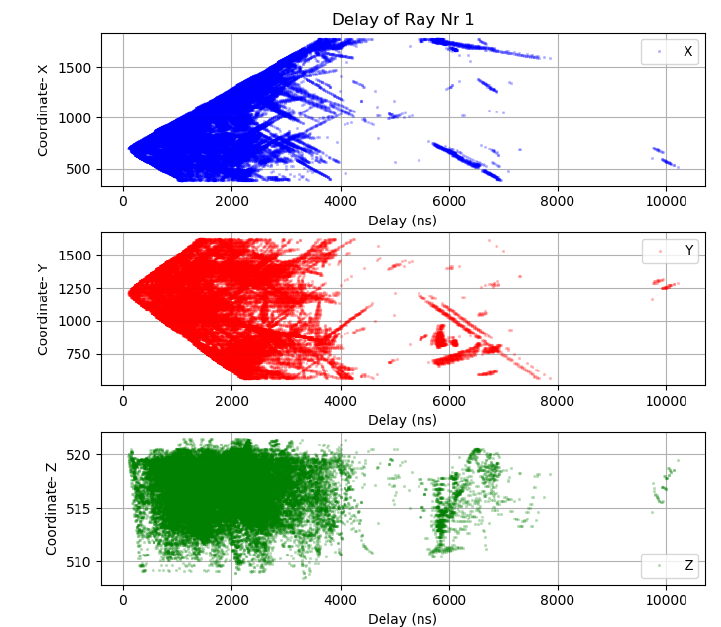
Figure 19. Ray-tracing delay fingerprint Sensor